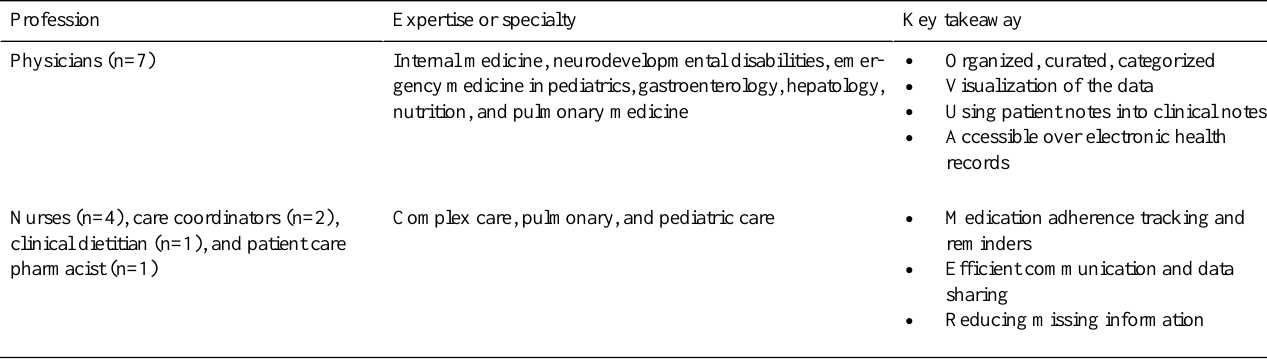
Table 4. Health care provider feedback.